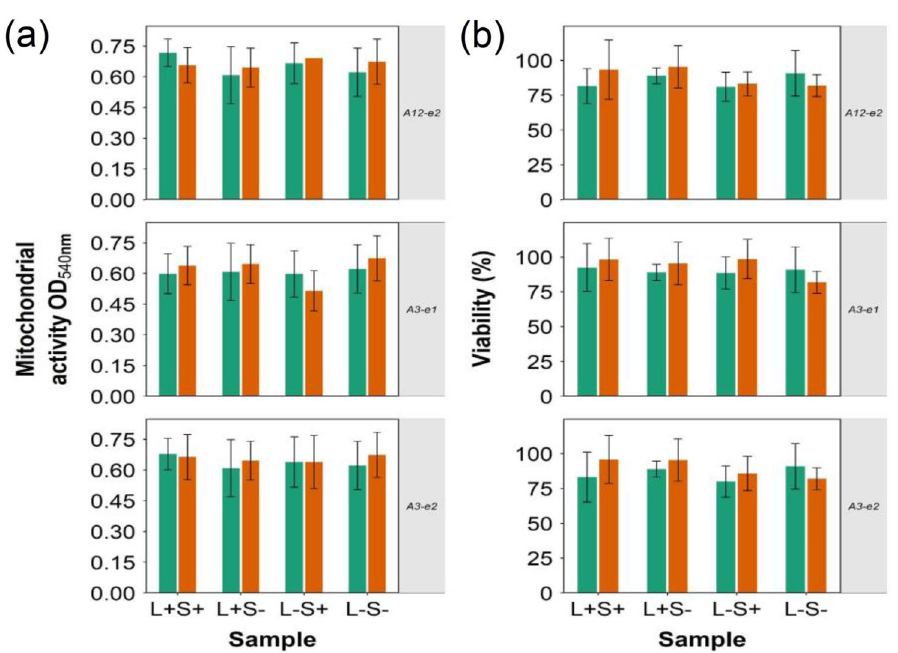
Figure 11. MTT and LDH on keratinocytes (green circles) and fibroblasts (orange circles) exposed to TBO and TBO–PBAEs (mean ± SD, n =